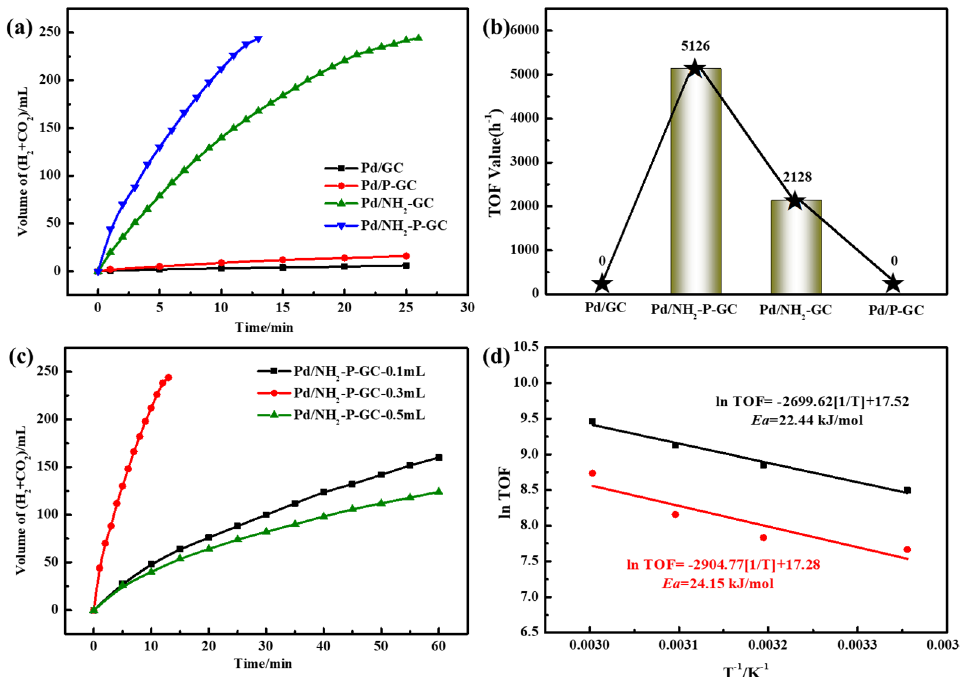
Figure 3. ( a ) Gaseous generation during the decomposition of FA versus time in the presence of Pd with/without different supports or APTES and ( b ) the corresponding TOF value ( c ) comparative gaseous product generation for varying amounts of APTES in Pd/NH 2 - P - GC; ( d ) the calculated activation energy at different sample temperatures. (Black line representative of Pd/NH 2 - P - GC sample, red line representative of Pd/NH 2 -GC sample) (Reaction conditions: 5 mL 1.0 M FA, n Pd /n FA =